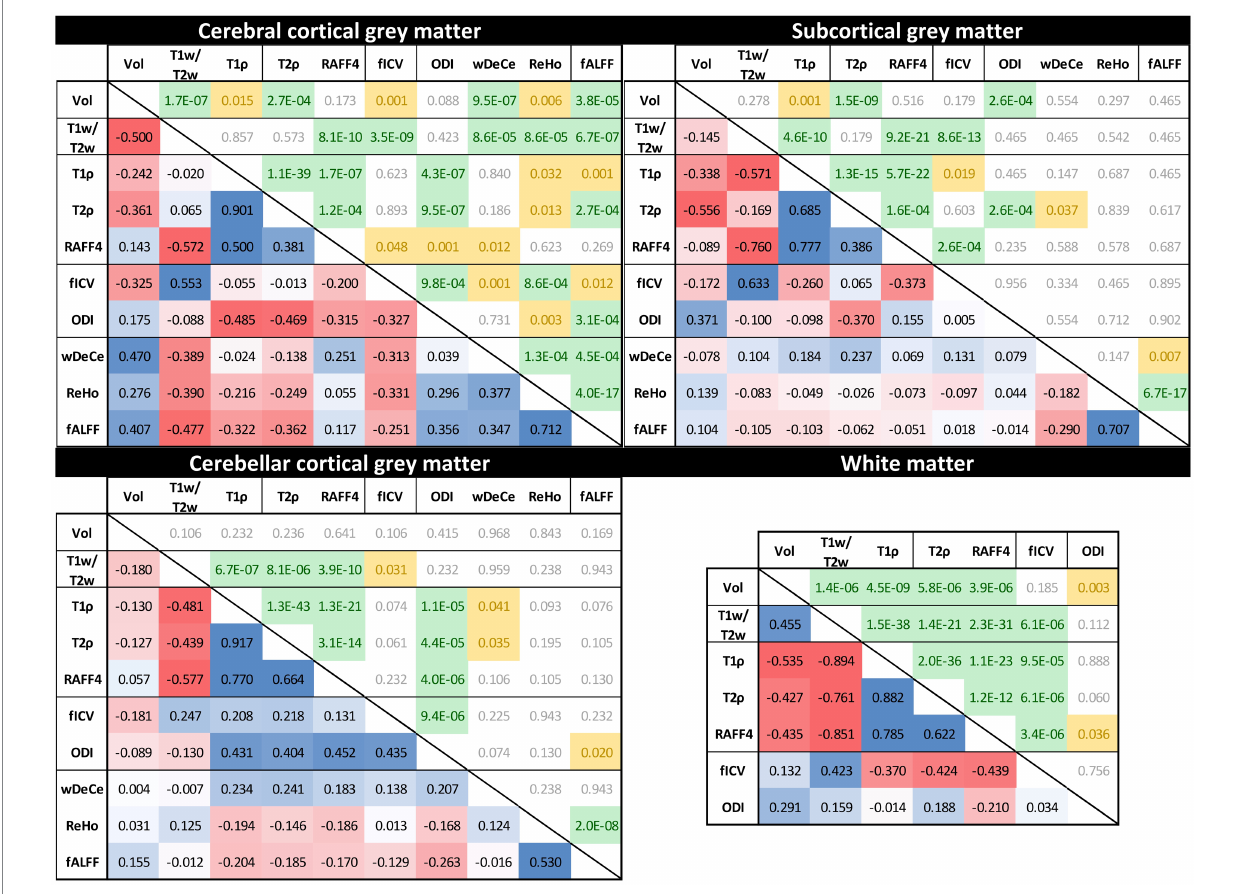
FIGURE 4 Rank cross-correlation matrices between individual MRI metrics across the four predetermined regions of interest [cerebral cortical grey matter (GM), subcortical GM, cerebellar cortical GM and white matter (not provided for resting-state fMRI metrics)]. Numbers in the lower triangle represent Spearman’s correlation coefficients (positive correlations in blue and negative correlations in red). The upper triangle of each matrix contains False discovery rate-corrected p -values ( p -values < 0.001 in green, p -values between 0.001 and 0.05